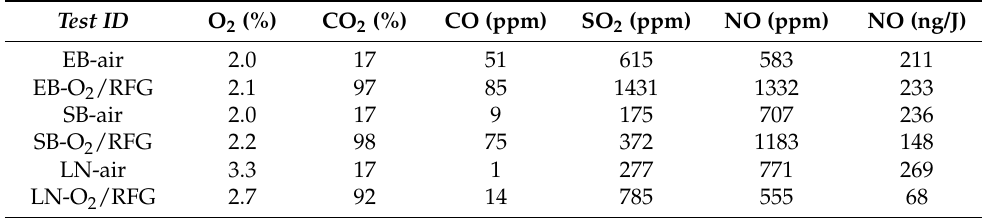
Table 3. Exhaust gas compositions used for